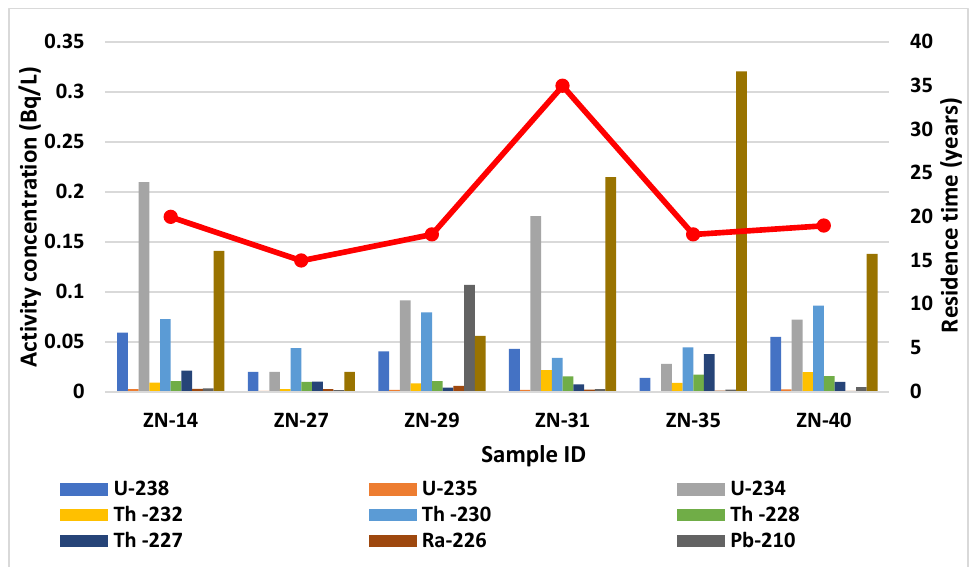
Figure 6. Activity concentration of tritium ( 3 H) in groundwaters with variable residence time from the West Rand area ( n = 6).